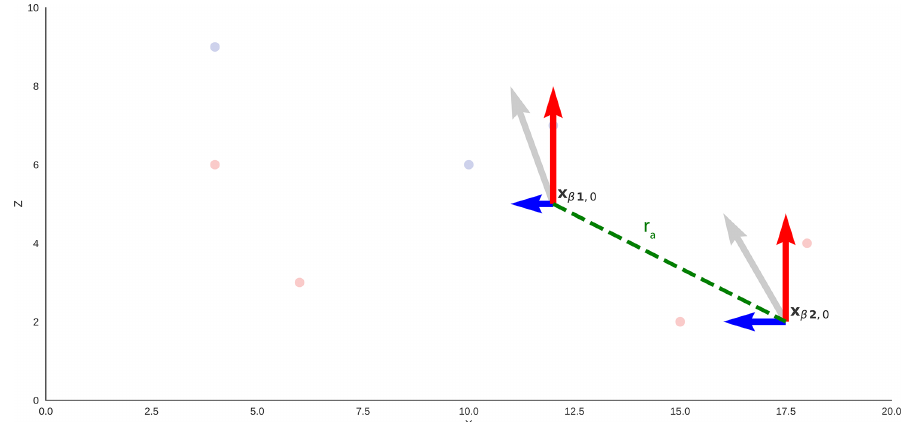
Figure B1. 2-D representation of the decomposition of the orientation vectors into Cartesian axes. Each Cartesian axis represents a variable of a sub-cokriging system. The dashed green line represents the covariance distance, r a , for the covariance of the gradient.